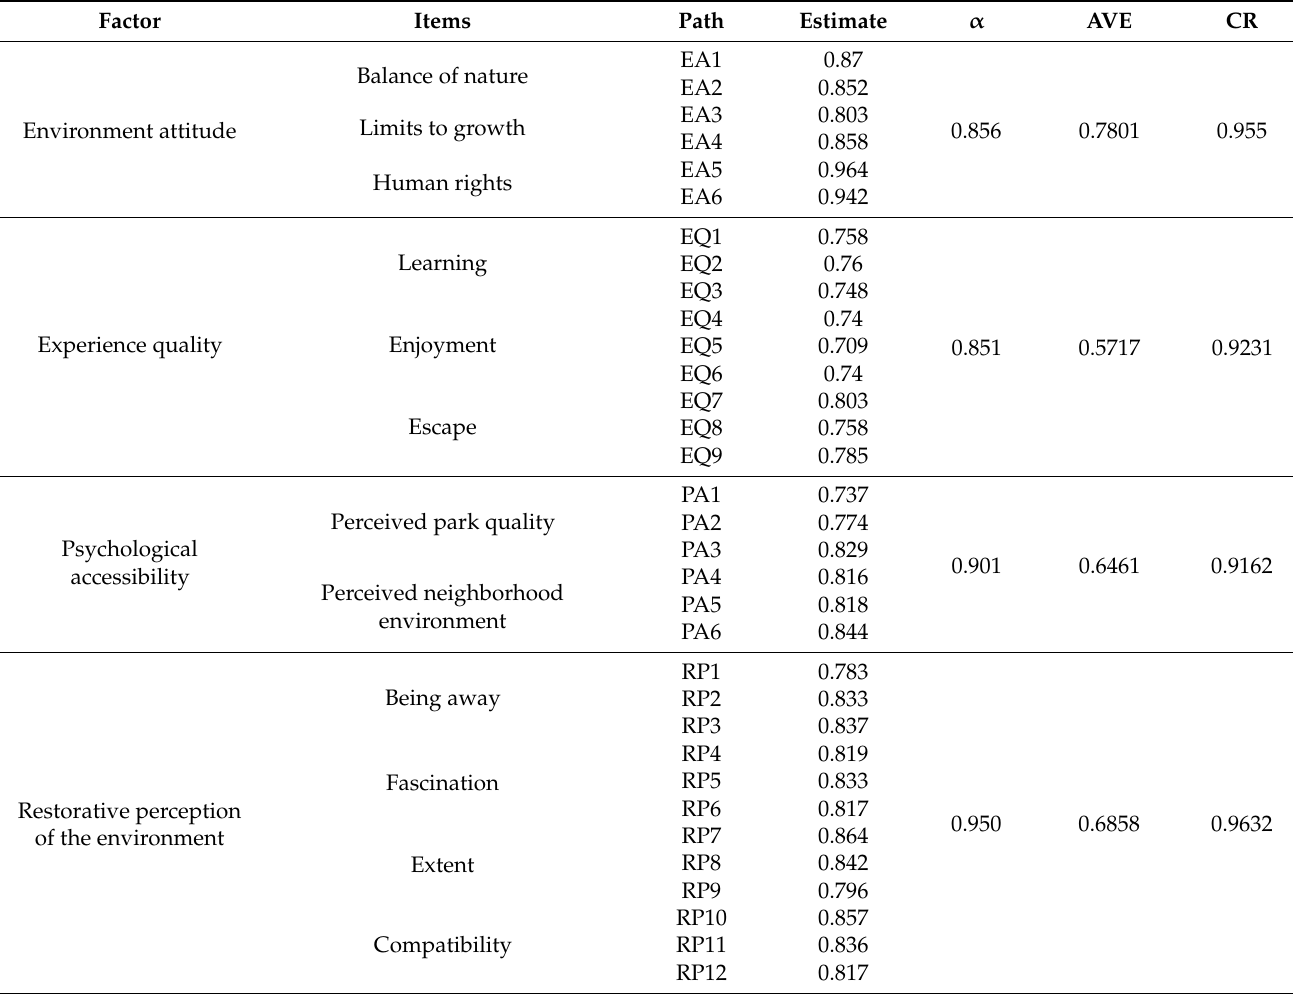
Table 7. Results of the validation factor